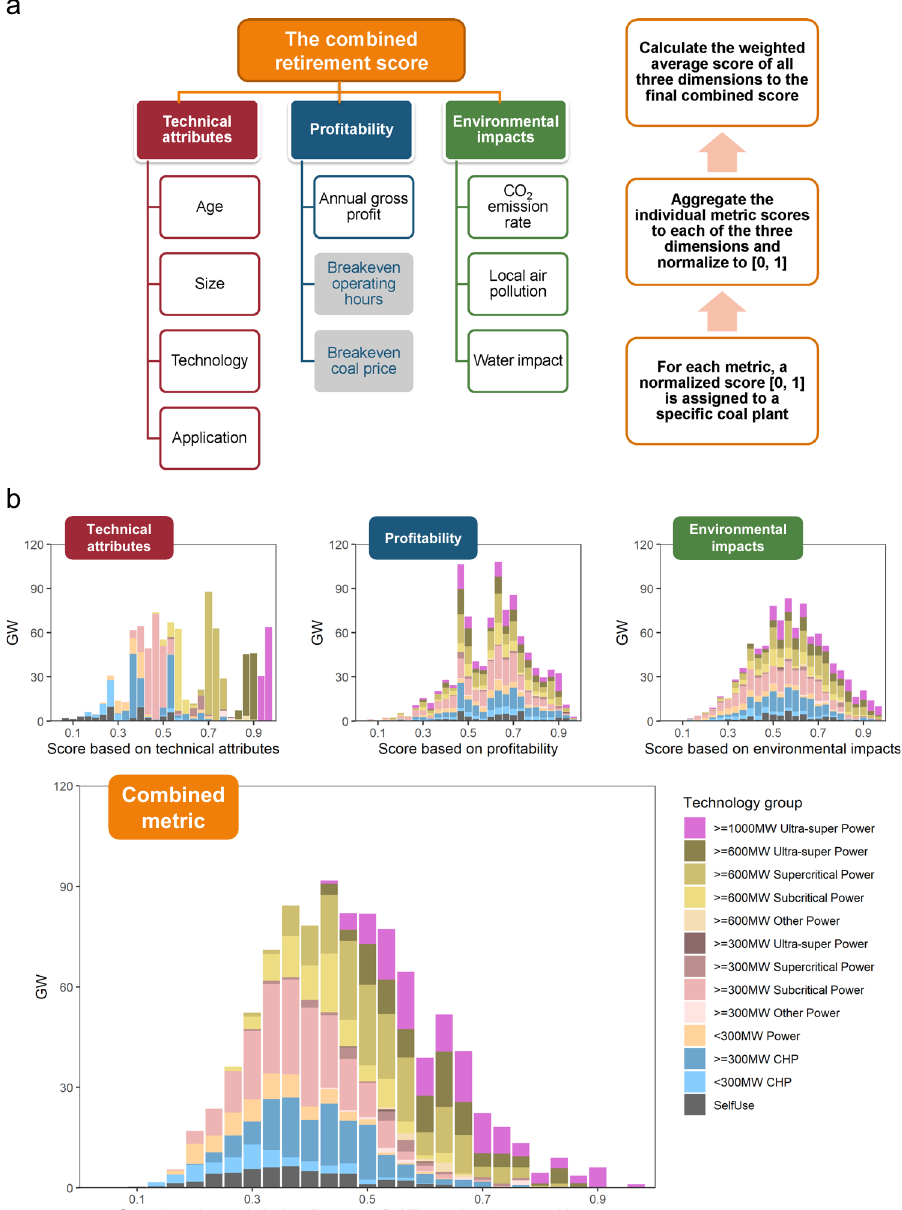
Fig. 2 Retirement score of individual coal plants. a Methodology of calculating the combined plant-by-plant retirement algorithm: the score of technical attributes is based on the equal-weighted average of plant age, size, combustion technology, and application; the score of pro fi tability is based on capacity weighted annual gross pro fi ts; and the score of environmental impacts is based on the equal-weighted average of CO 2 emission rates, air pollution and health impacts, and water impacts. b The combined score is based on the equal-weighted average of the three dimension scores (each score is normalized between zero and one). The combined score, from zero to one, ranks all operating plants from fi rst to last for retirement. Overall, plants to retire fi rst are older, smaller, less ef fi cient, self-use plants located in highly air polluted and water scarce